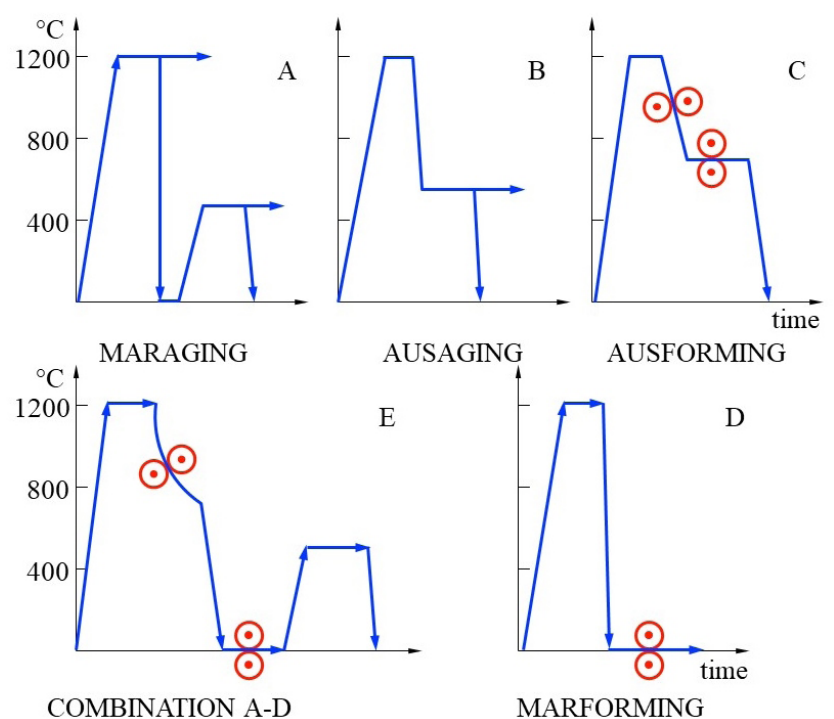
Figure 6. Time-temperature diagrams illustrating different treatments and their combinations. Horizontal lines with arrows indicate the variable austenitizing (1200 °C) periods for intercritical annealing (700 °C) and aging (450-600 °C) 12